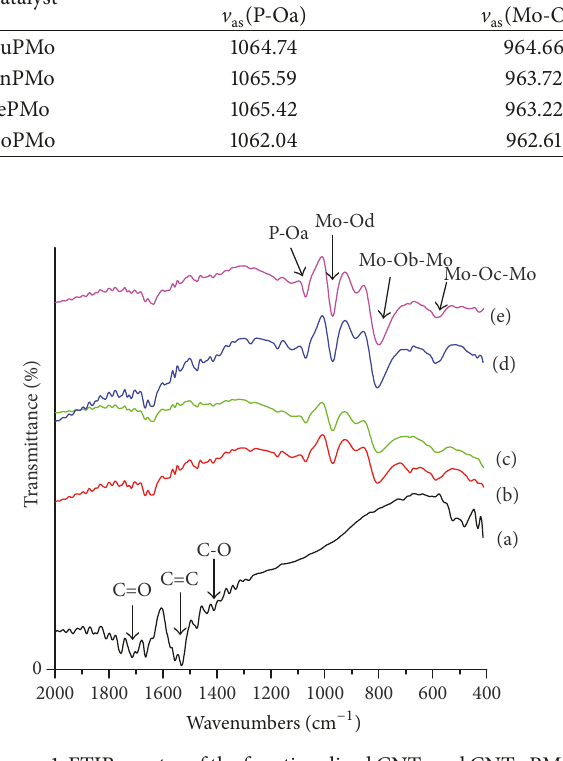
Figure 1: FTIR spectra of the functionalized CNTs and CNTs-PMo- 𝑥 series of catalysts. (a) Functionalized CNTs; (b) CNTs-FePMo-150; (c) CNTs-FePMo-200; (d) CNTs-FePMo-250; (e) CNTs-FePMo- 300; (f) CNTs-FePMo-350.